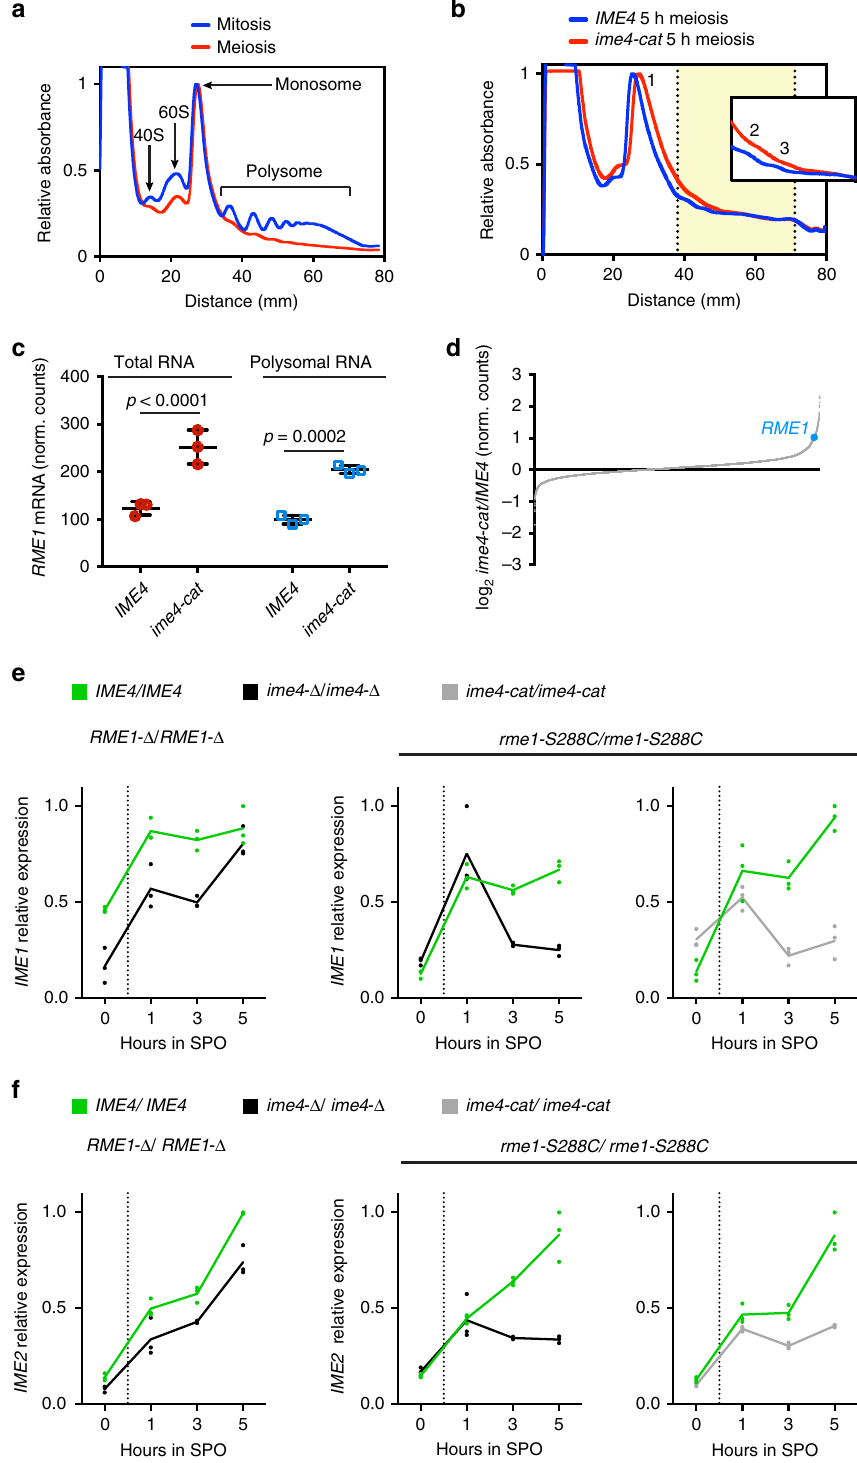
IME4 / IME4 and ime4- Δ / ime4- Δ cells after 5 h in SPO media (Fig. 2e). By contrast, in the rme1-S288C / rme1-S288C back- meiotic DNA ground, IME1 levels were reduced more than three-fold in both ime4- Δ / ime4- Δ and ime4-cat / ime4-cat cells relative to IME4 / IME4 cells (Fig. 2e). Analysis of the time courses showed that an initial burst of IME1 expression was induced equally in IME4 / IME4 , ime4- Δ / ime4- Δ , and ime4-cat / ime4-cat cells, but ime4- Δ / ime4- Δ and ime4-cat / ime4-cat cells failed to